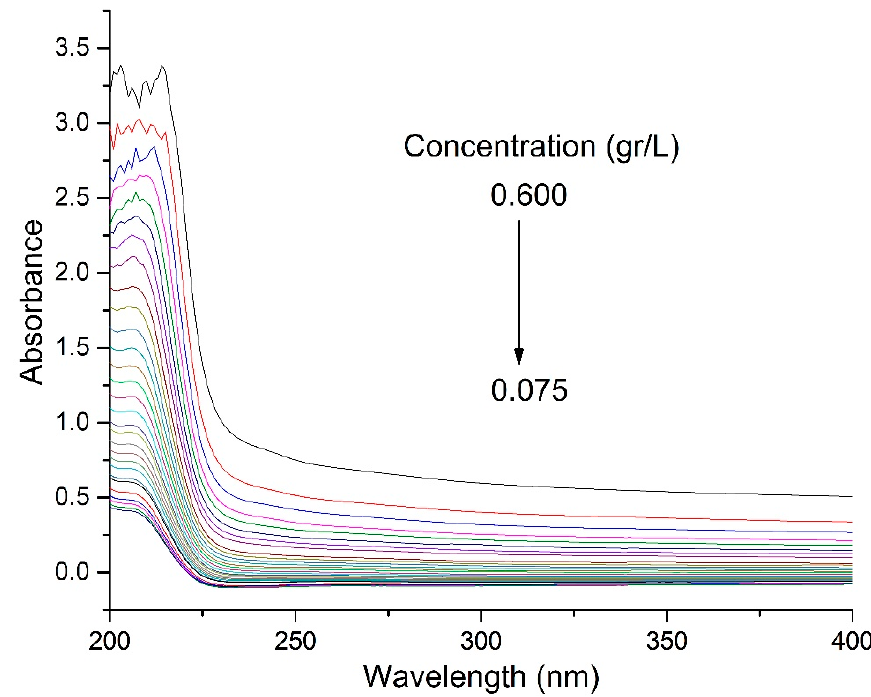
Figure 6. UV-Vis spectrum of bioconjugate of oleic acid and L-cysteine (MAT).